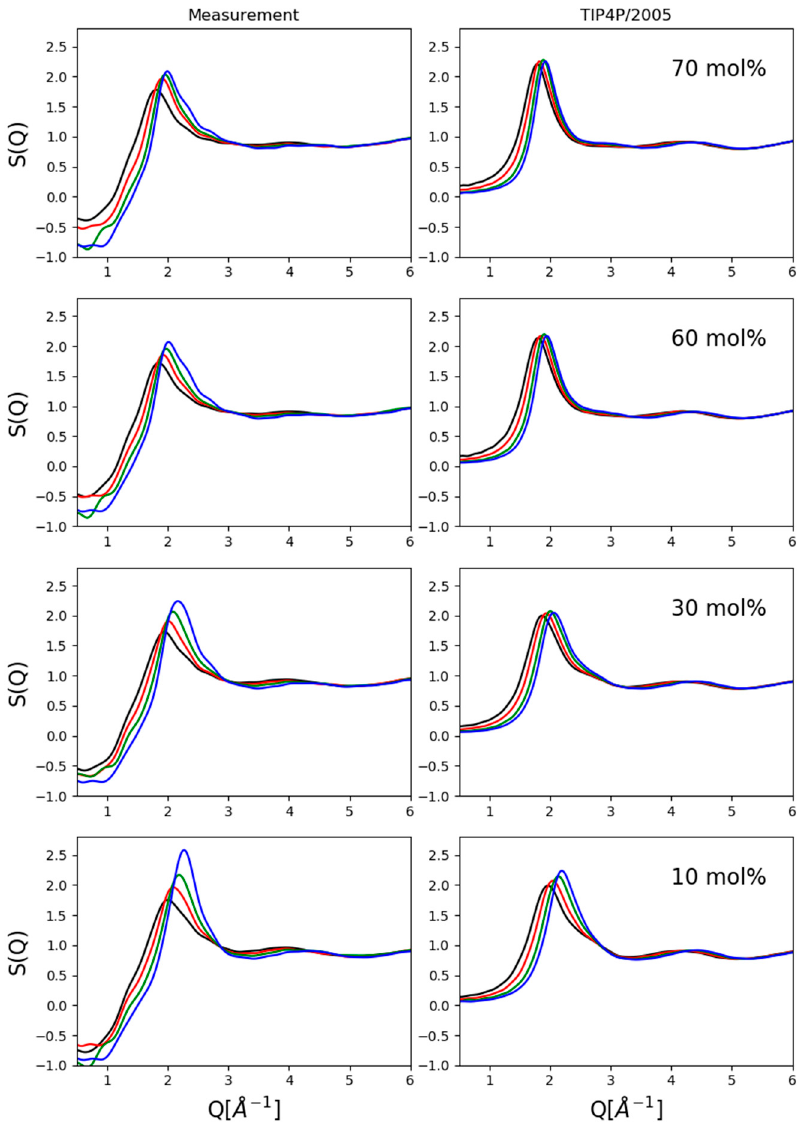
Figure 3. Comparison of measured data and computer simulation results with the TIP4P/2005 water potential as a function of pressure at given compositions. The upward shift of the first peak position with growing pressure was captured satisfactorily. Black lines: 0.15 GPa; red: 0.4 GPa; green: 0.8 GPa; blue: 1.2 Gpa.